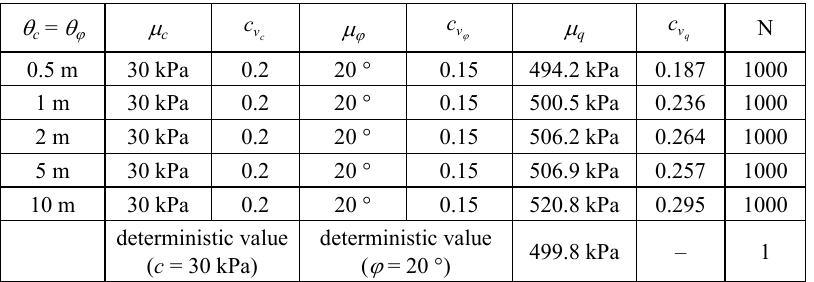
Table 3. Results of random analysis for cohesive-frictional soil obtained for different scales of